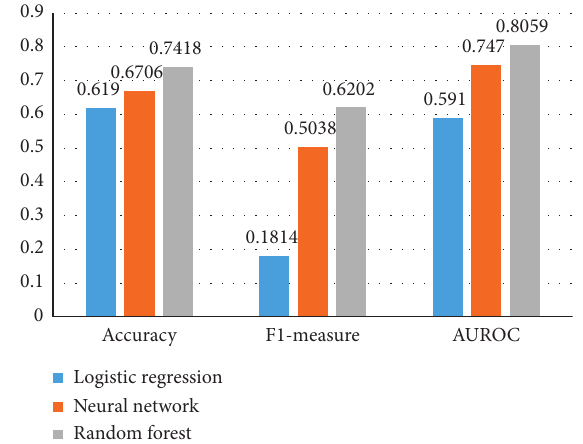
Figure 4: Prediction accuracy, F-measure, and AUROC for every model.